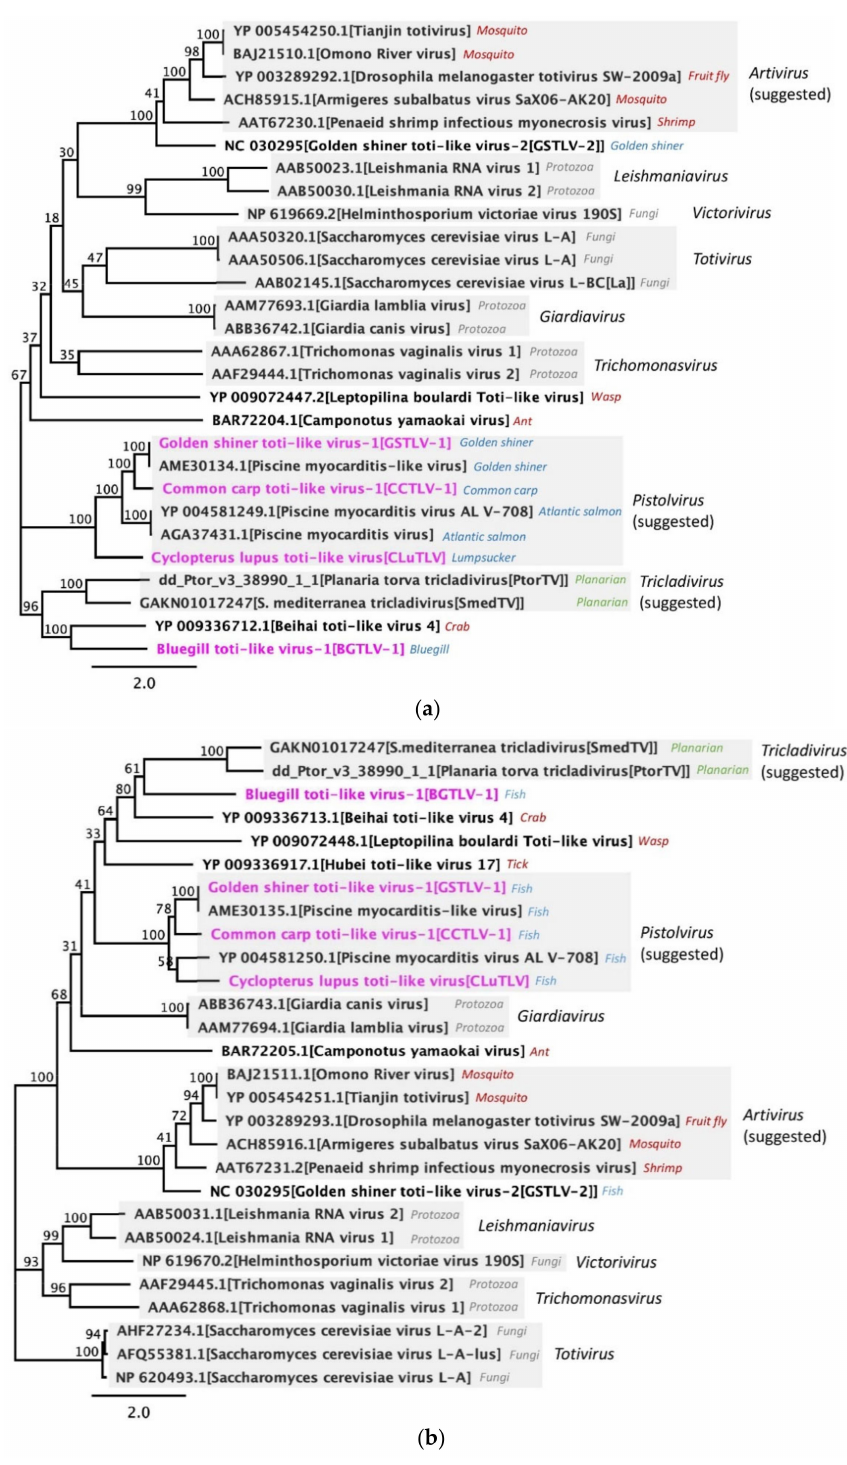
Figure 6. Phylogenetic relation of the six piscine toti-like viruses to members of the family Totiviridae and non-registered toti-like viruses, with annotations of registered and suggested new genera. The novel piscine toti-like viruses are highlighted in pink. The remaining viruses are referred to by GenBank accession numbers and virus name. Common host specie names are included for reference (uni-cellular organisms in grey, arthropods in red, planarians in green and fish in blue). Suggestions of new genera are according to Dantas et al., 2016 [41], Burrows et al., 2020 [7] and present work. The tree was constructed based on the complete capsid protein (ORF1) in ( a ) and complete RdRp protein (ORF2) in ( b